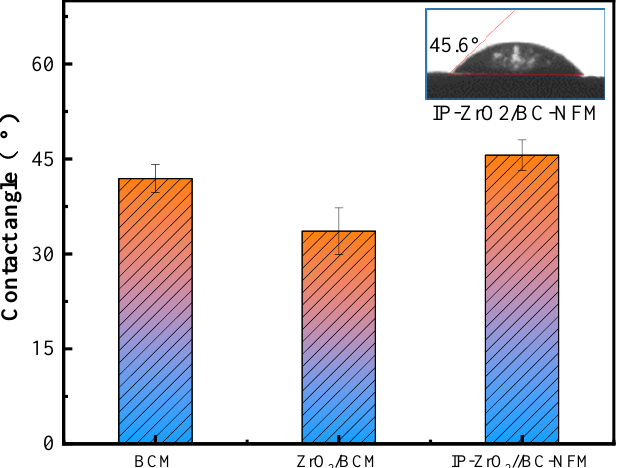
Figure 13. Images of the contact angle of BCM, ZrO 2 /BCM, and IP − ZrO 2 /BC − NFM. To evaluate the pore size of the NFM, different molecular weights of PEG were tested for their interception effects. A smaller pore size was more beneficial to the separation performance of the membrane. Figure 14 shows that the intercepted molecular weight of IP − ZrO 2 /BC − NFM was 692 Da, and the calculated membrane aperture was 0.638 nm.